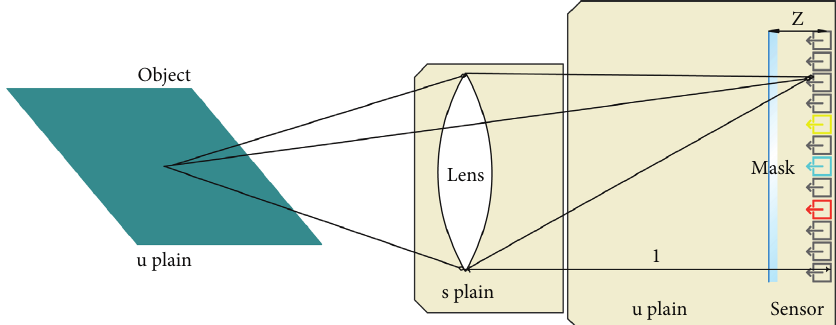
Figure 1: Schematic diagram of the structure of the compressed light field camera.